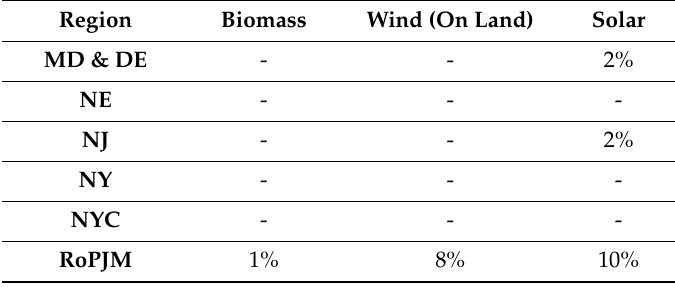
Table A13. Minimum Percentage of Total Regional Dispatch from Renewable Energy Sources (General Electric International,